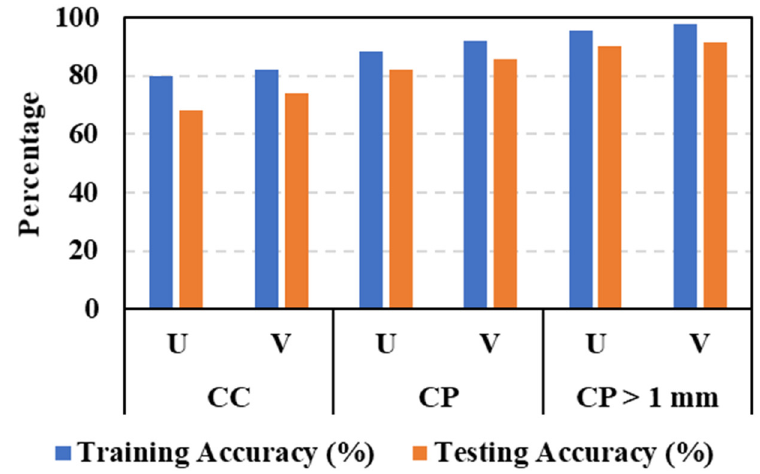
performance is also analyzed for a longer crack corresponding to CP > 1 mm. The training